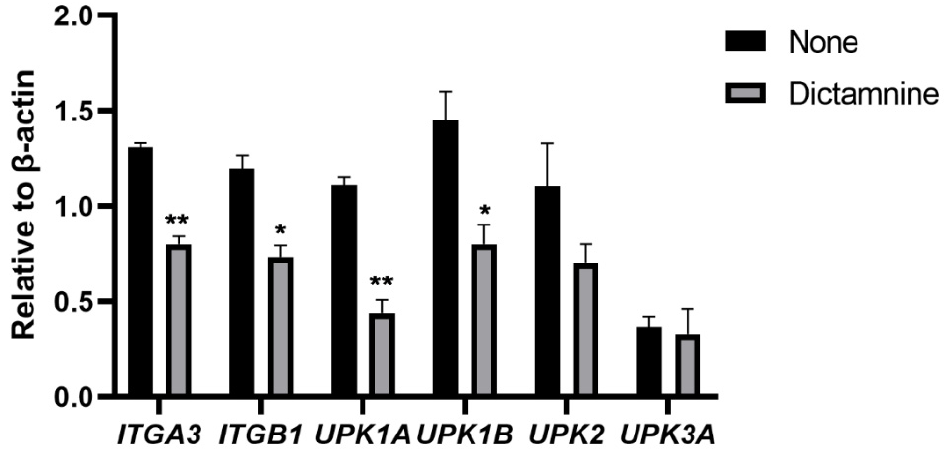
Figure 6. Expression of integrin and uroplakin genes in T24 bladder epithelial cells treated with dictamnine determined by RT-qPCR. * p < 0.05, ** p < 0.01.